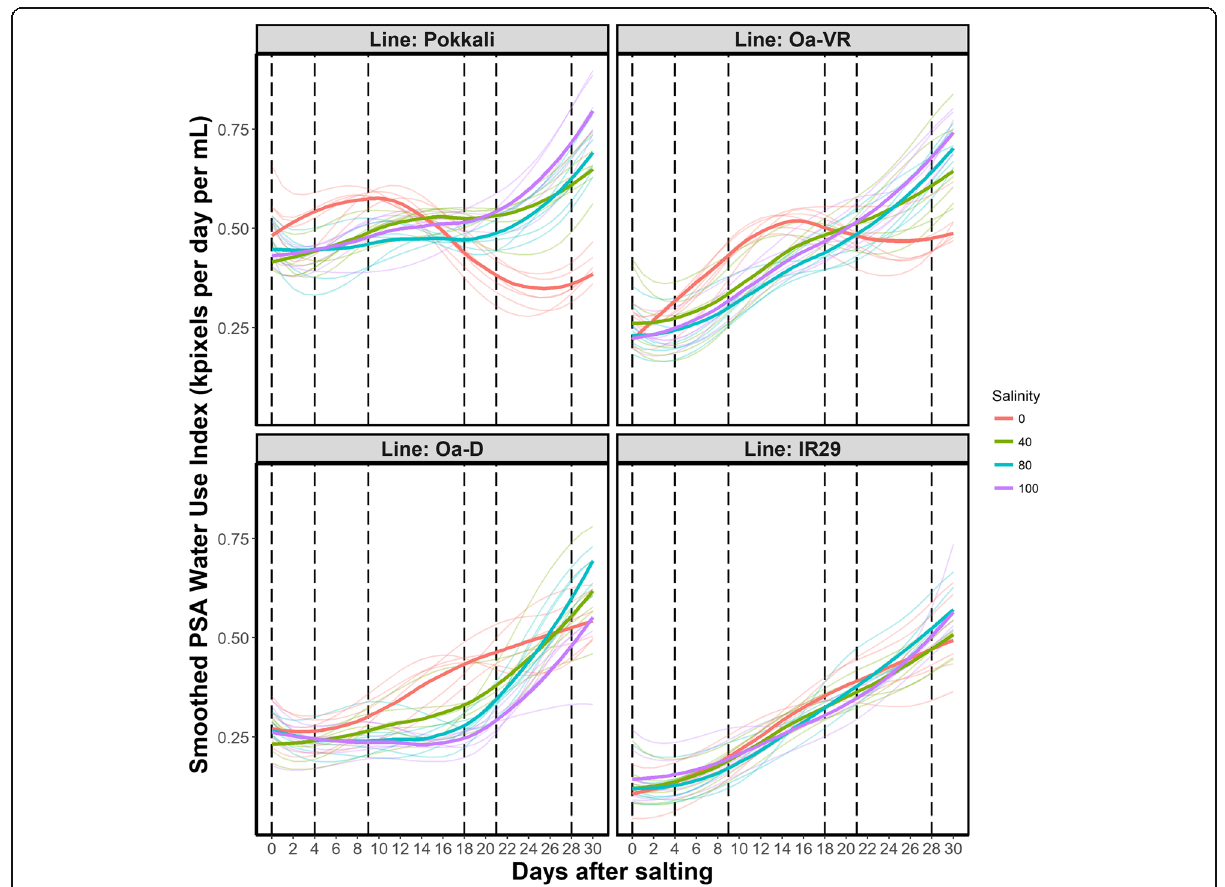
Fig. 5 Relationship between growth and water use during salt treatment. Smoothed PSA Water Use Index is shown for the selected genotypes under salt treatments and non-salinised control conditions. The values were obtained by dividing the total increase in sPSA for each interval by the total water loss in the same interval. Thin lines represent individual plants. Bold lines represent the grand average of the six replicates for each treatment. Vertical broken lines represent the tested